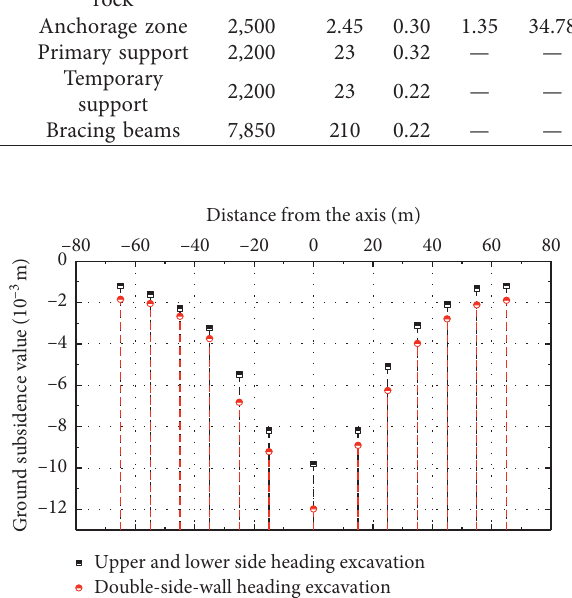
Figure 4: Curve of surface subsidence